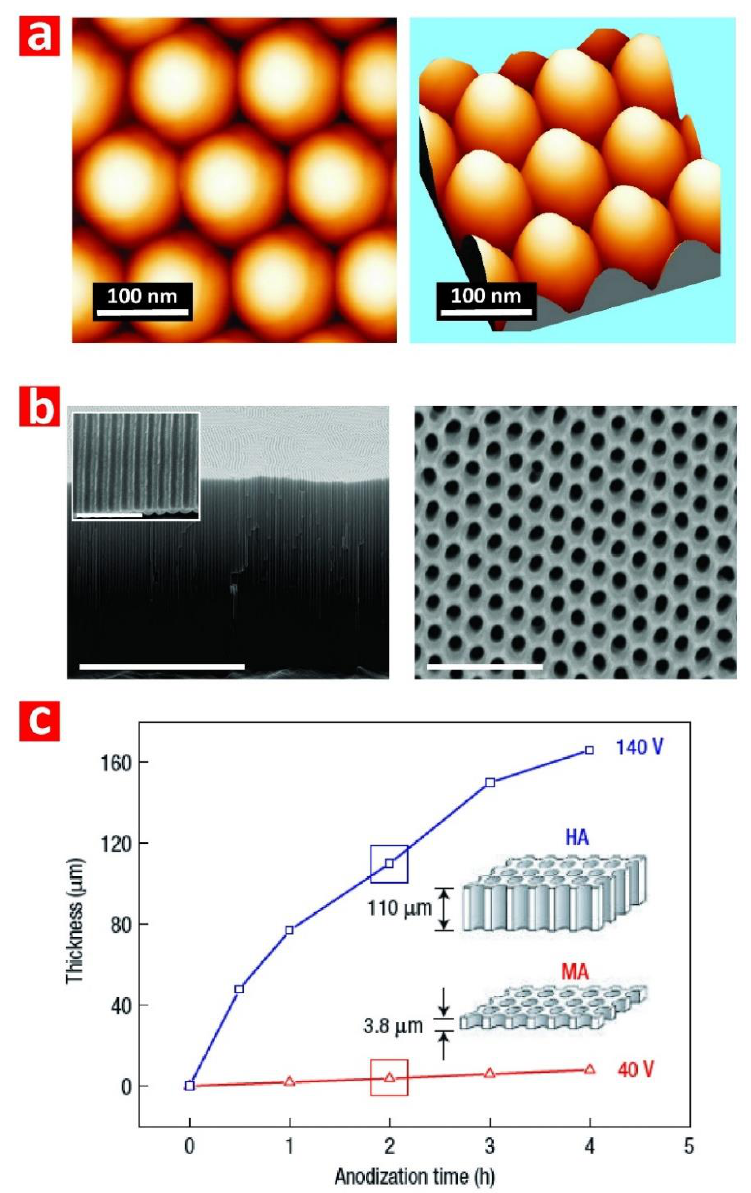
Figure 3. Self-organized nanoporous anodic alumina (NAA). ( a ) Atomic force microscopy images showing details of the hemispherical caps located at the bottom side of NAA produced by two-step anodization. ( b ) General cross-sectional FEG-SEM view of NAA featuring straight cylindrical nanopores from top to bottom (scale bar = 5 µm) with inset showing a magnified view of the oxide barrier layer (scale bar = 500 nm) and top FEG-SEM view of hexagonally arranged cylindrical nanopores in NAA (scale bar = 500 nm). ( c ) Film thickness as a function of anodization time at mild (MA at 40 V—red line) and hard anodization (HA at 140 V—blue line) with schematics showing the different thicknesses of anodic oxides after 2 h of anodization. Reproduced from [33], with copyright permission from Springer Nature, 2006.